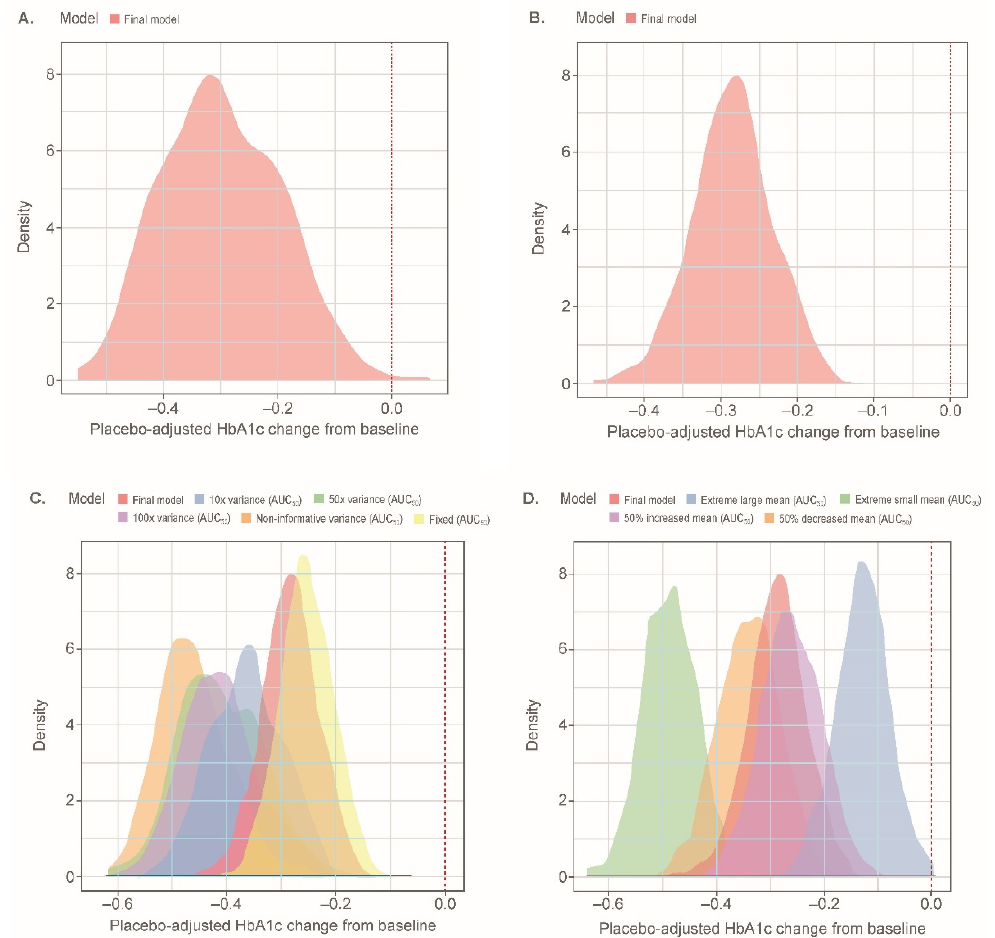
Figure 3. Distributions of simulated median placebo-adjusted HbA1c (%) change from baseline at week 26 for a 2.5-mg empagliflozin treatment arm in the EASE-2 population: ( A ) with the semi-mechanistic model; ( B ) with the descriptive model; ( C ) with different prior variances; ( D ) with different prior means. Distributions represent simulated median values for 500 replicates including parameter uncertainty for each respective model. Extreme large mean: 22,026 nmol·h/L; Extreme small mean: 0.00005 nmol·h/L. AUC 50 , AUC ss leading to 50% of maximal effect; AUC ss , area under the curve at steady-state; HbA1c, glycated hemoglobin.